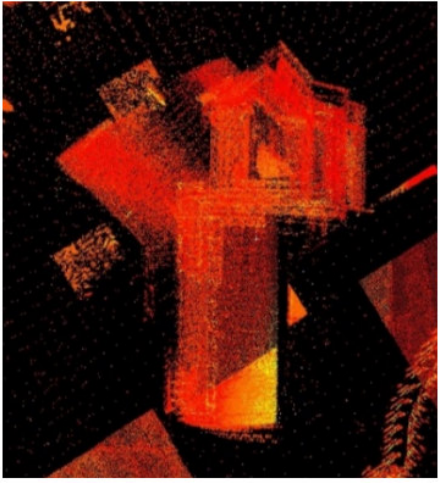
Figure 10. LAS format data from ALS successful imported in Cyclone 7.3 software.